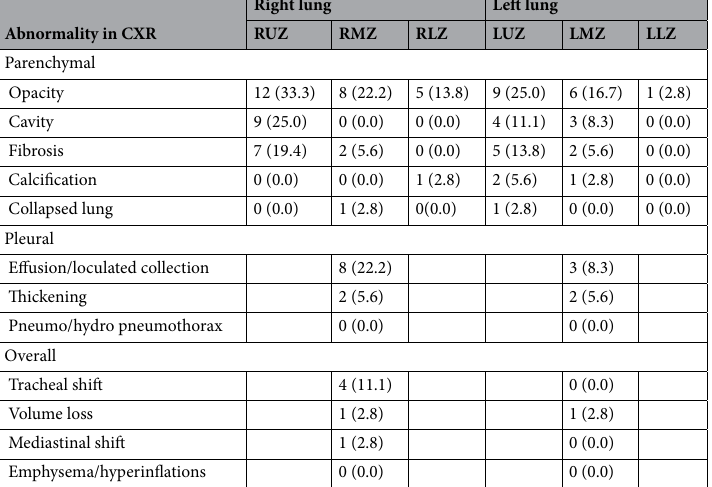
Table 2. Distribution of radiological abnormalities in external test set—lung wise and zone wise representation used in the model. All values represented n (%) format. RUZ right upper zone, RMZ right mid zone, RLZ right lower zone, LUZ left upper zone, LMZ left mid zone, LLZ left lower